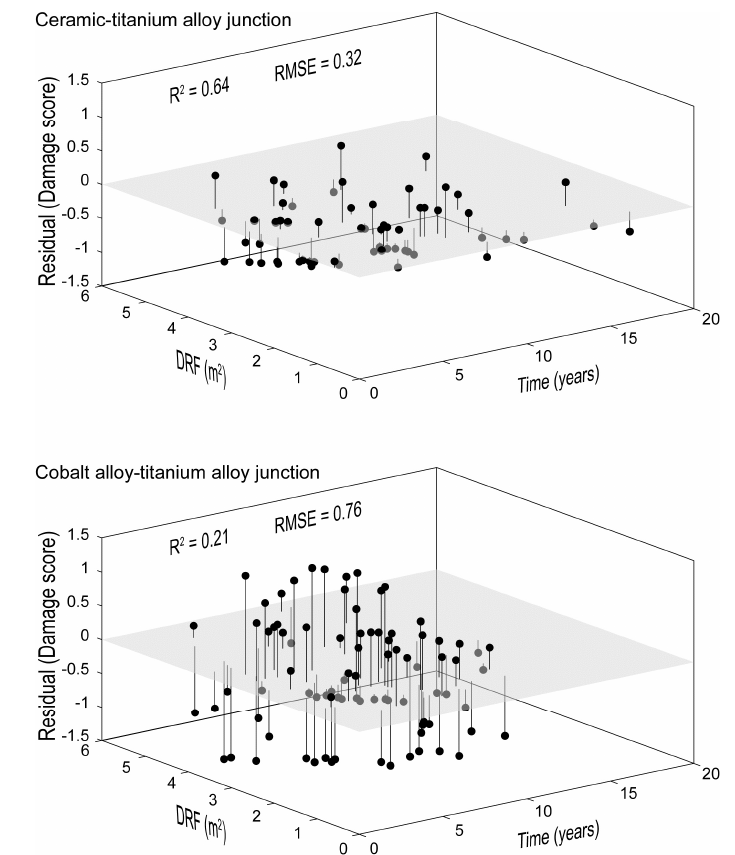
Figure 4. Plot of residuals versus implantation time and DRF. R 2 and root mean square error (RMSE) calculated for each material combination are reported. Table 4. Pearson’s correlation coefficients between age at implantation, BMI, implantation time, and DRF (sample size N = 148).